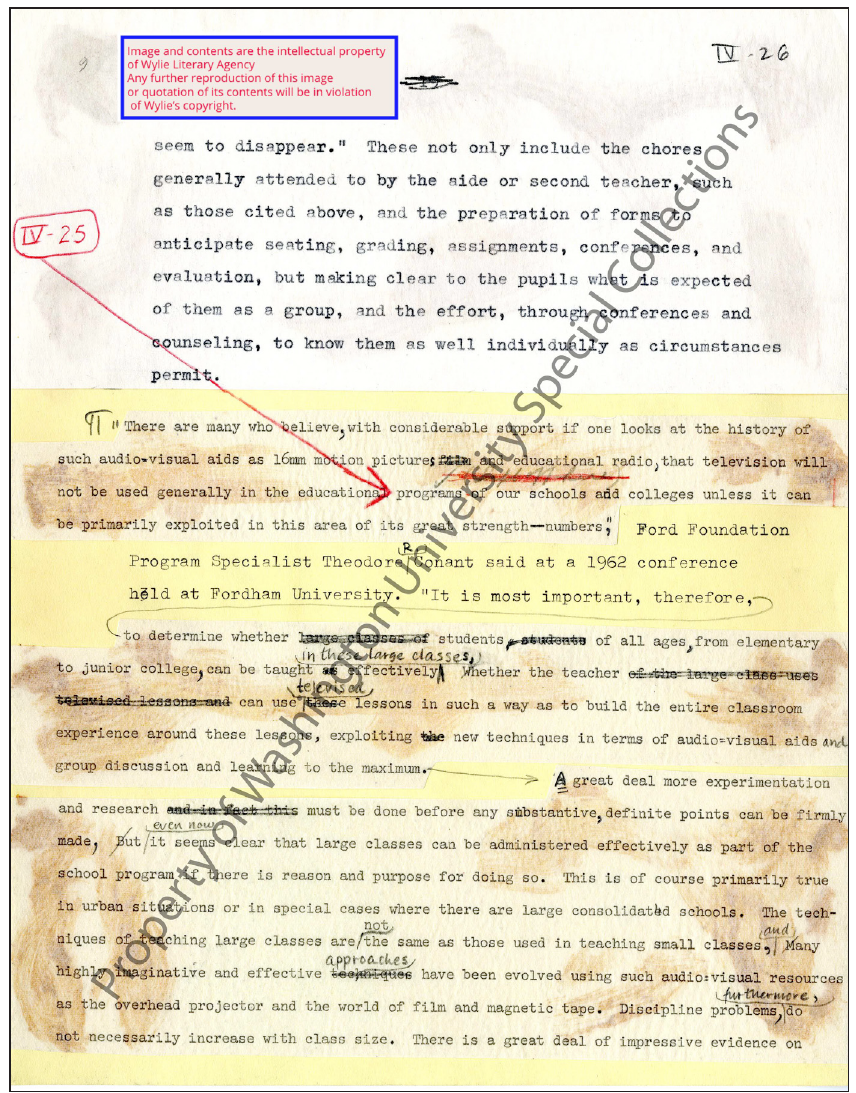
Figure 5: A Fiasco draft page in cut-and-paste